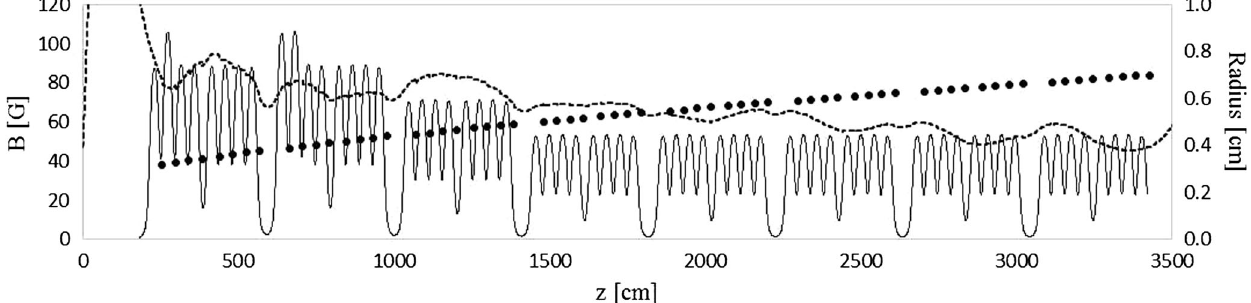
FIG. 2. Left Axis — The axial magnetic field of the Axis I solenoids (solid line) and the magnetic field needed to suppress the IDI as calculated by Eq. (7) (dots). Right Axis — The radius of the electron beam (dashed line).